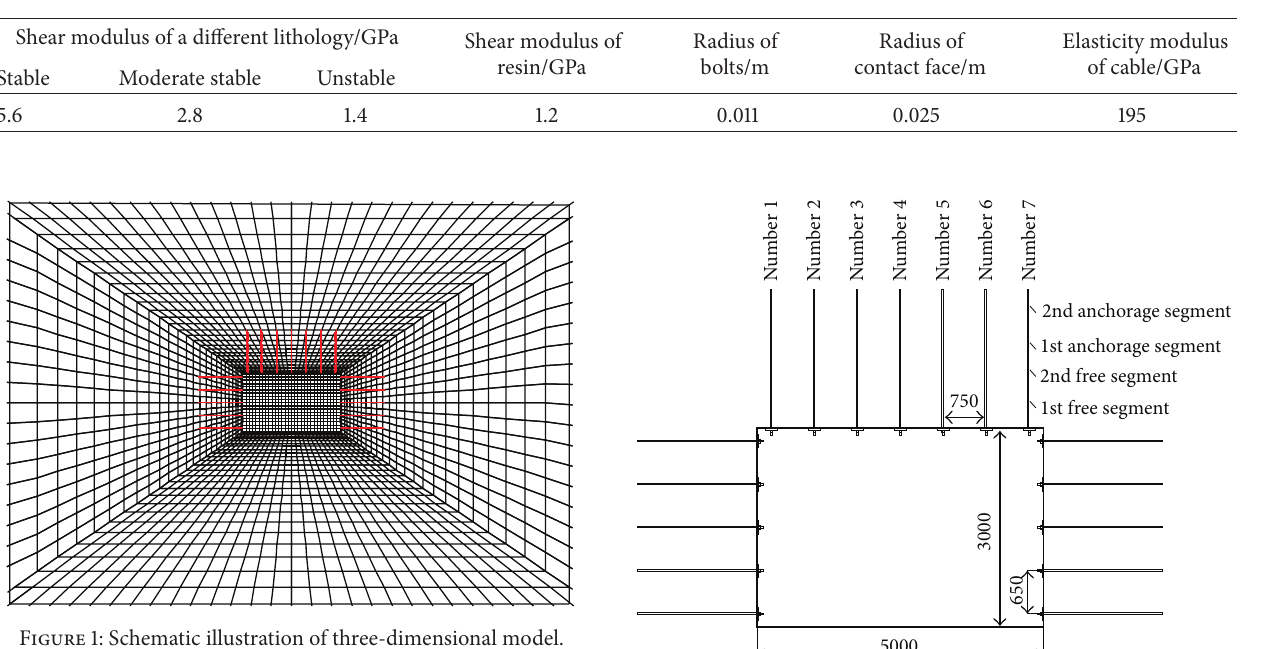
Table 1: Initial parameters for fitting curves of shear stress.